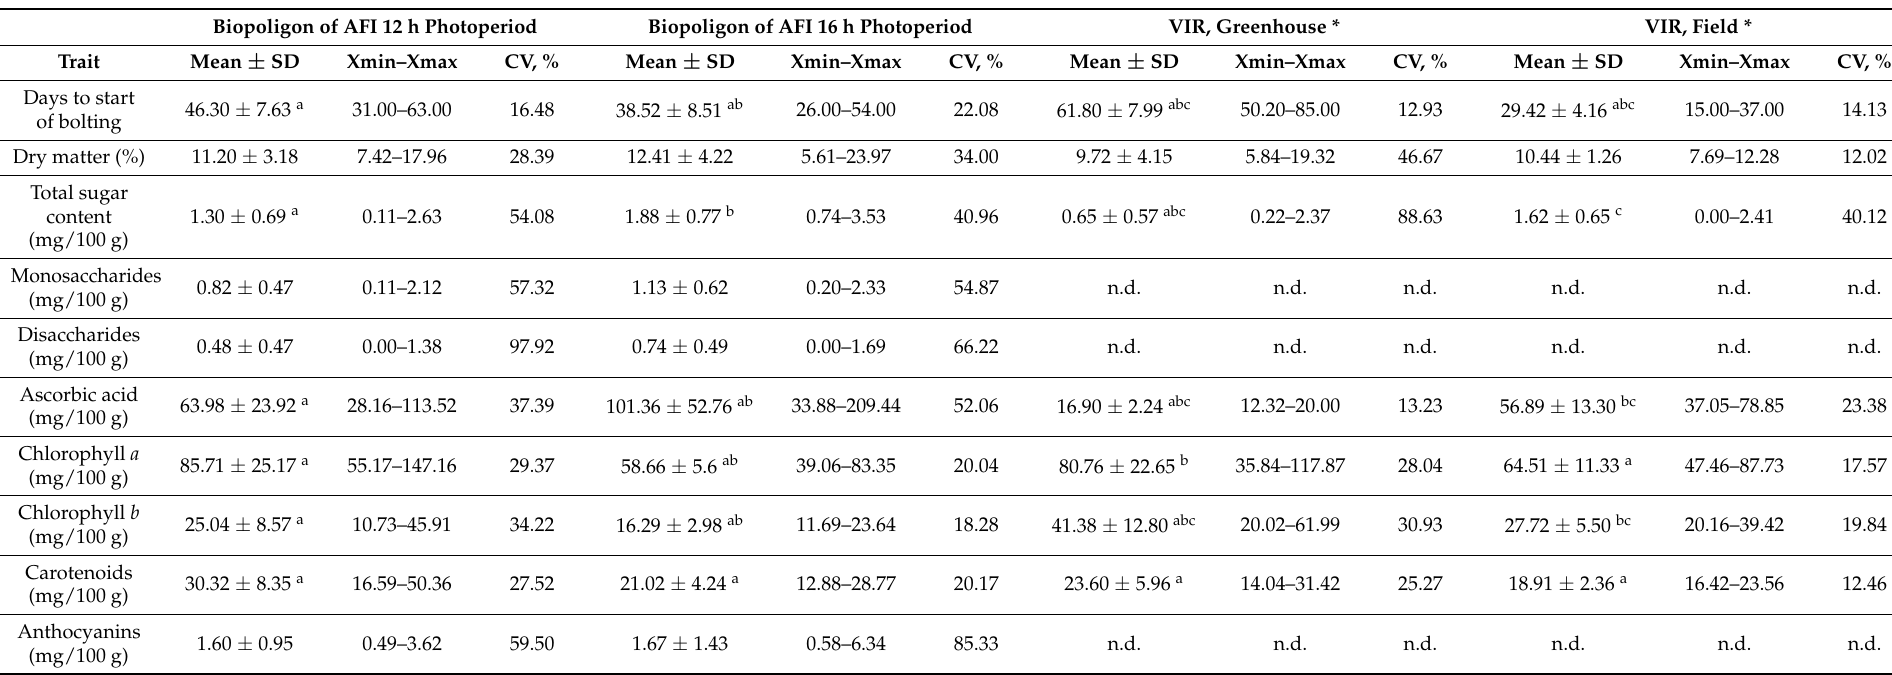
Table 1. The timing of the start of bolting and the content of nutrients and biologically active substances in the lines of the mapping population DH 30. Biopoligon of AFI 12 h